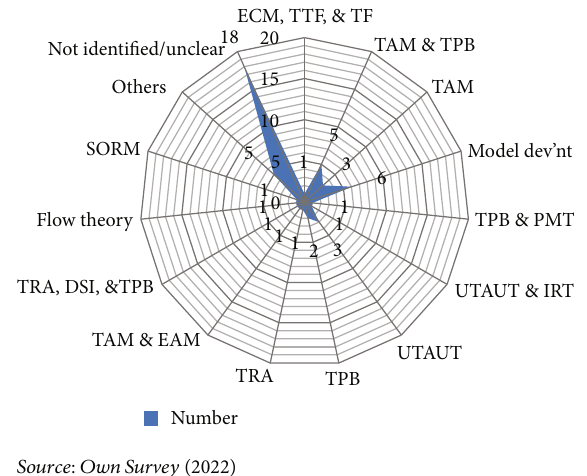
Figure 5: Online consumer behavior studies by country.